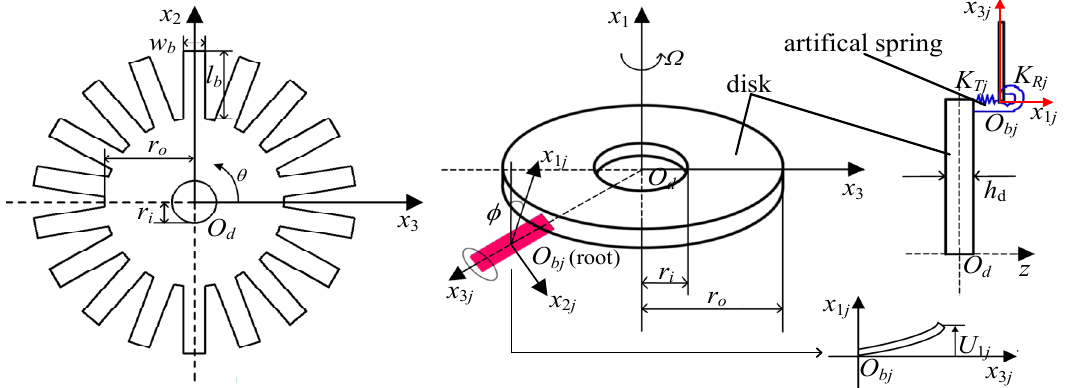
Figure 1. The analytical model of the blisk with hard ‐ coating blades.